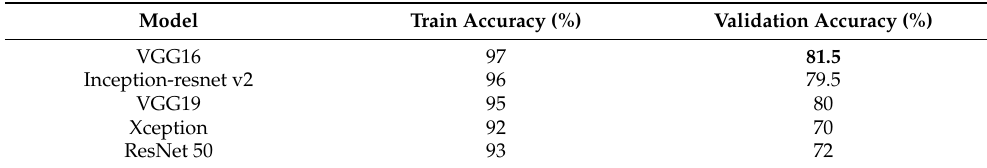
Table 1. Comparison of the fine-tuned pre-trained model accuracies of image patches. Bold font value indicates the highest value.